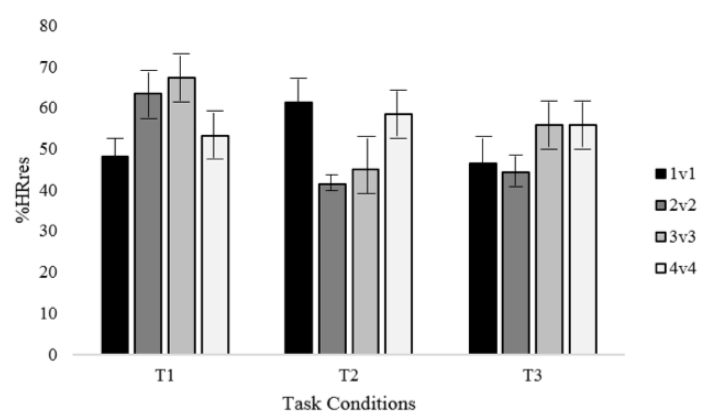
Figure 2. Values of mean (and SD) of heart rate responses (%HRres) for SSG formats and task conditions. T1: cross the opponent’s endline and receive the ball from one teammate; T2: cross the opponent’s targets and receive the ball from one teammate; T3: the way to score was to cross the central endline with possession of the ball.